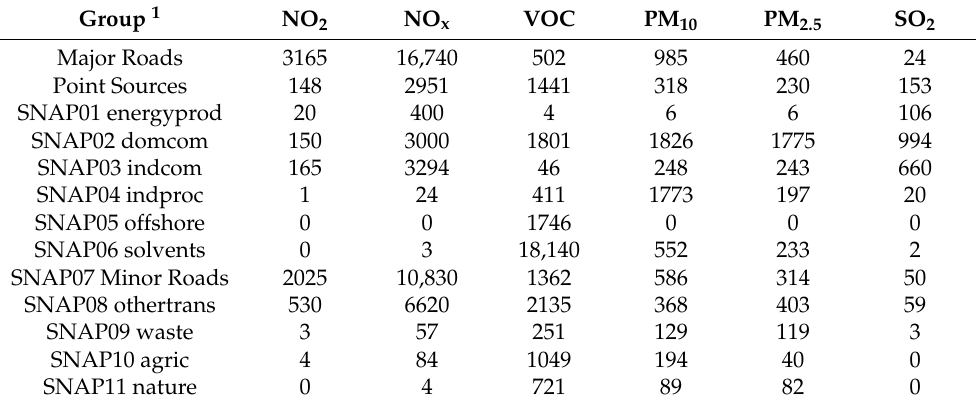
1 For SNAP sectors, see Section Grid